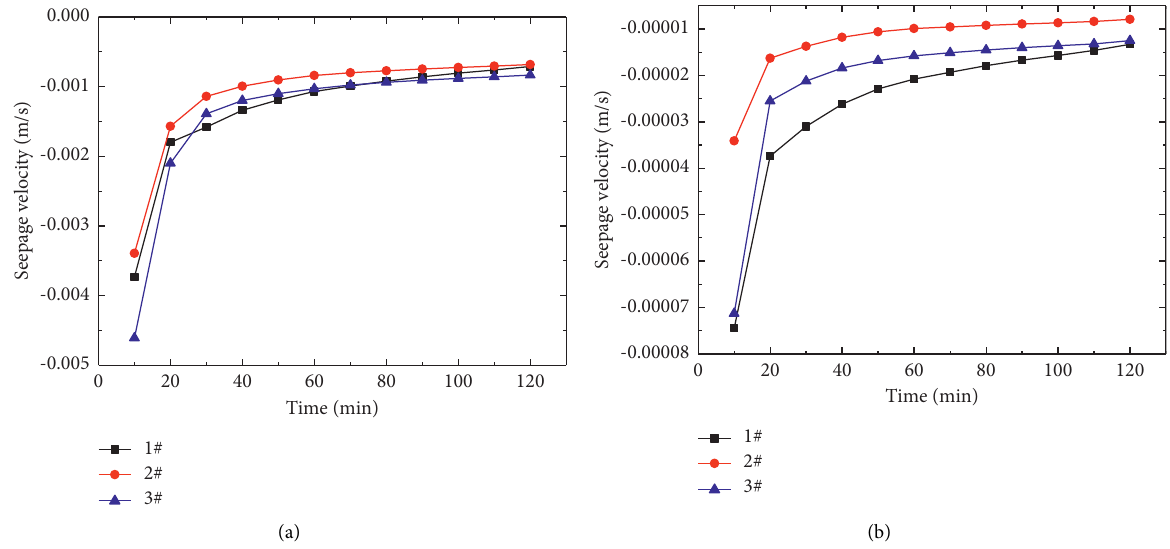
Figure 32: Infiltration velocity of observation points 1–3 of (a) buildings 1–2 and (b) buildings 2–4 with seepage wells placed around buildings 1 and 2 in the numerical model.